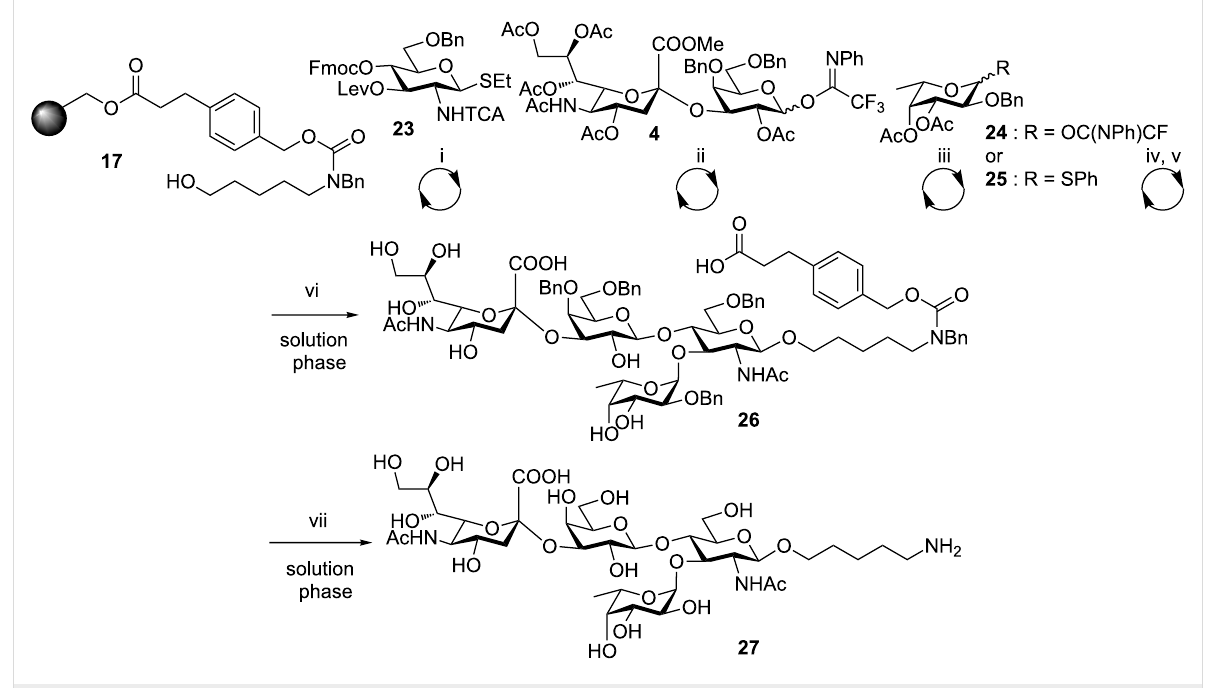
Scheme 5: Automated synthesis of 27 . Reagents and conditions: (i) (a) NIS, TfOH, dioxane, DCM, − 40 to − 20 °C, 40 min; (b) piperidine, DMF. (ii) (a) TMSOTf, DCM, 0 °C, 2 h; (b) NH 2 NH 2 ·H 2 O, AcOH, pyridine, DCM. (iii with 24 ) TMSOTf, Et 2 O, − 10 °C, 1 h. (iii with 25 ) NIS, TfOH, dioxane, DCM,